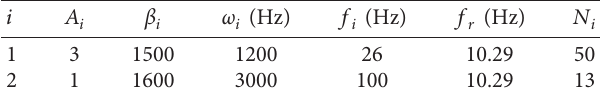
Table 1: Simulation